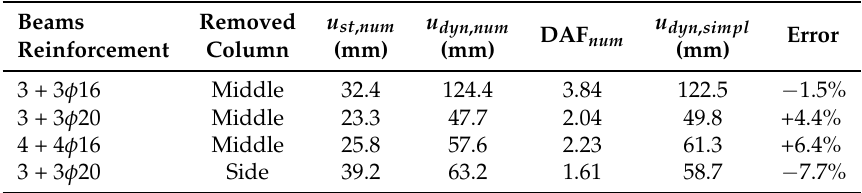
Figure 10. Time-histories of the downward displacement of the control point under the sudden column removal process (for both middle and side elements). Column removal starts at 0.1 s and lasts 0.01 s. The dashed lines illustrate the dynamic displacements obtained with the simplified method herein presented. Comparison between numerical and simplified analysis by varying the amount of reinforcement in the